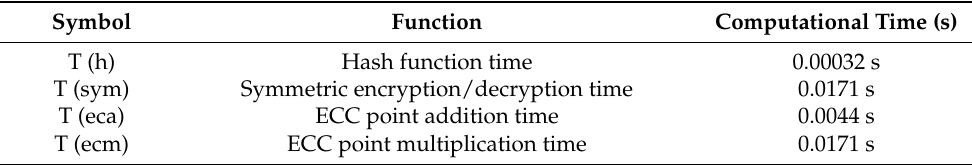
Table 4. Computational cost (CC) comparison in seconds.